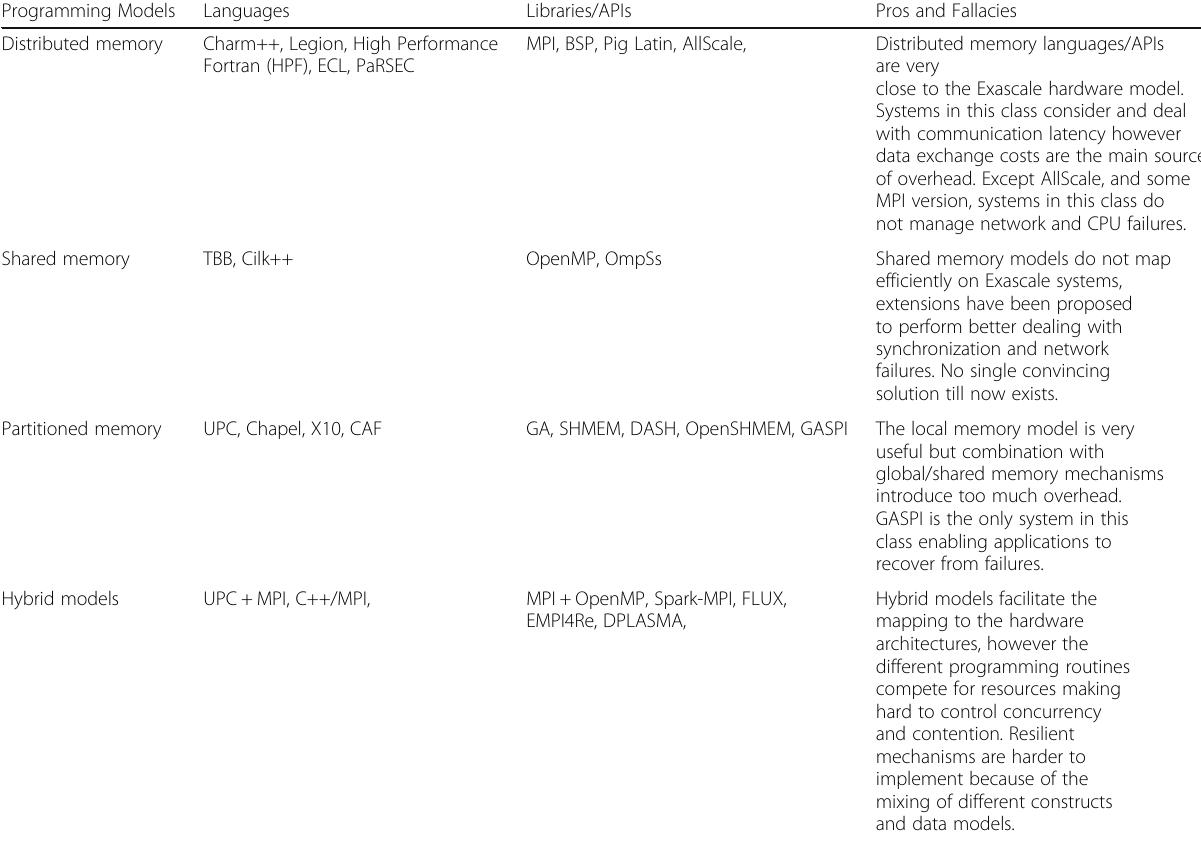
Table 1 Exascale programming systems classification Programming